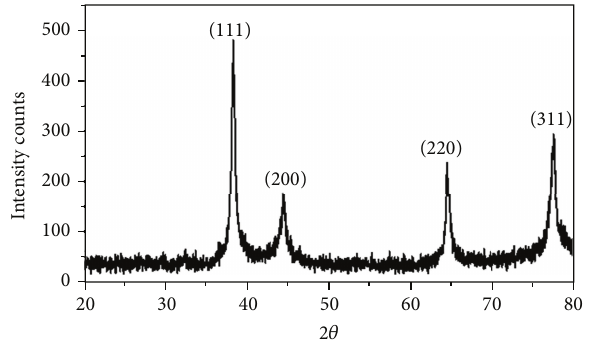
Figure 5: EDX spectrum of synthesized silver nanoparticles by M. tinctoria leaf extract.